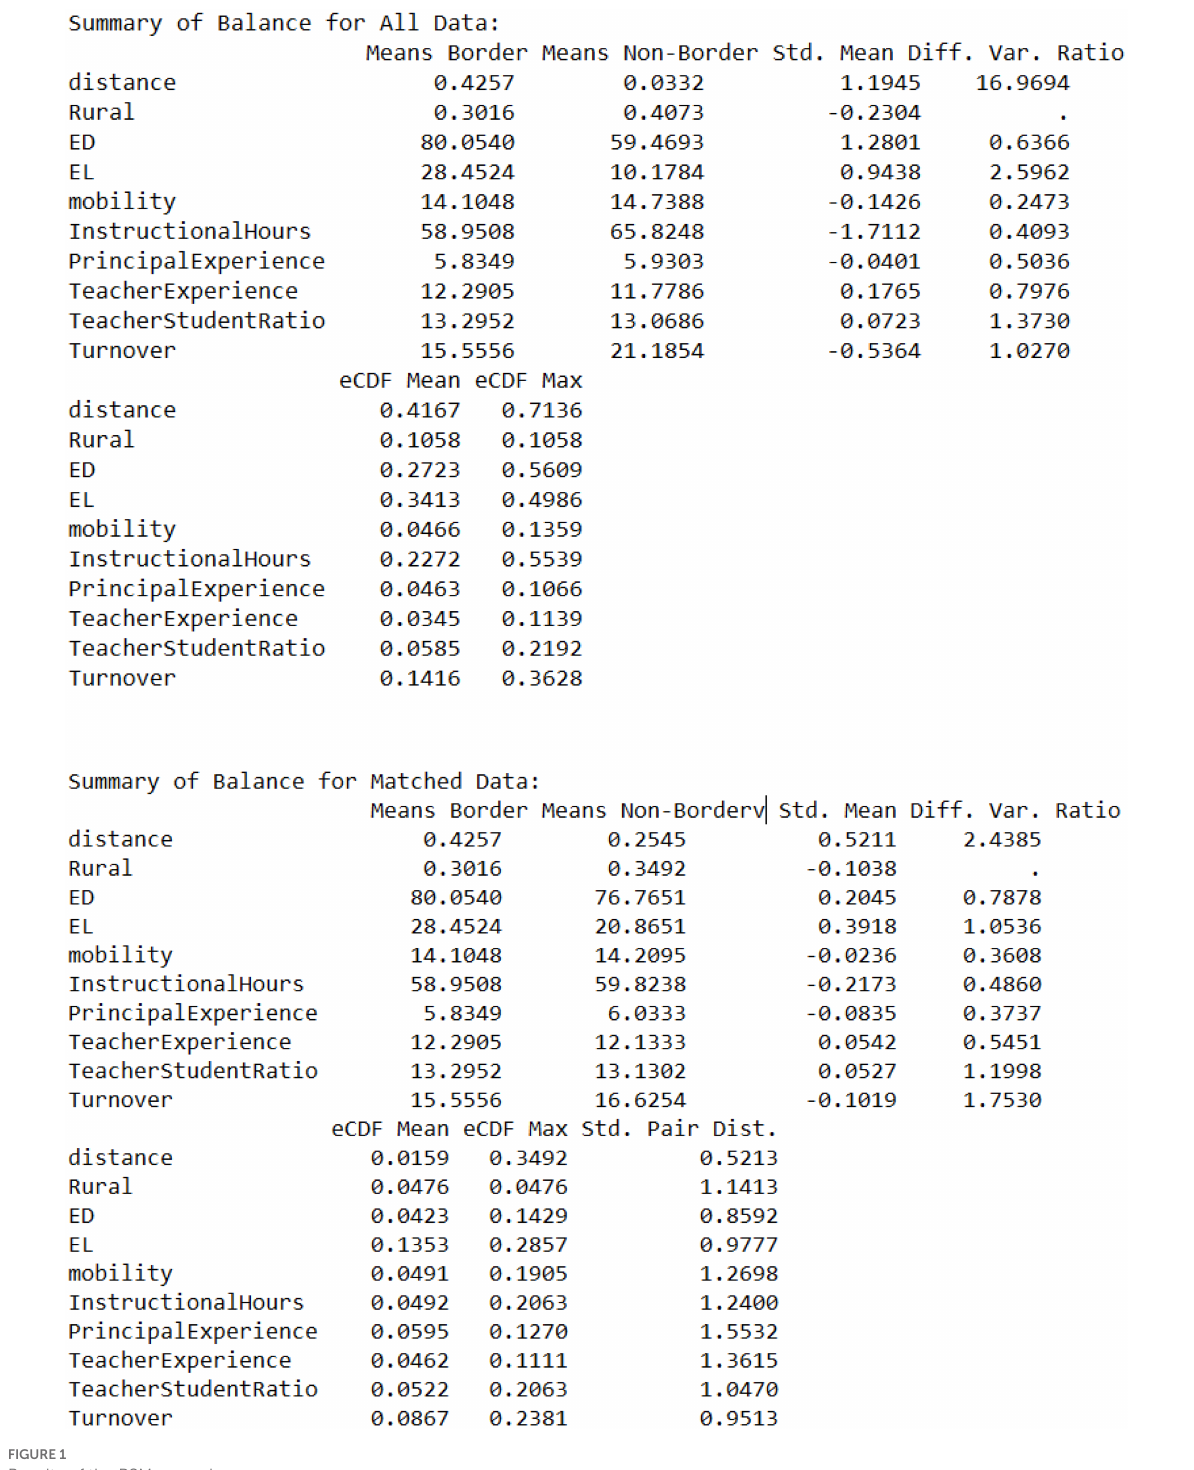
FIGURE 1 Results of the PSM